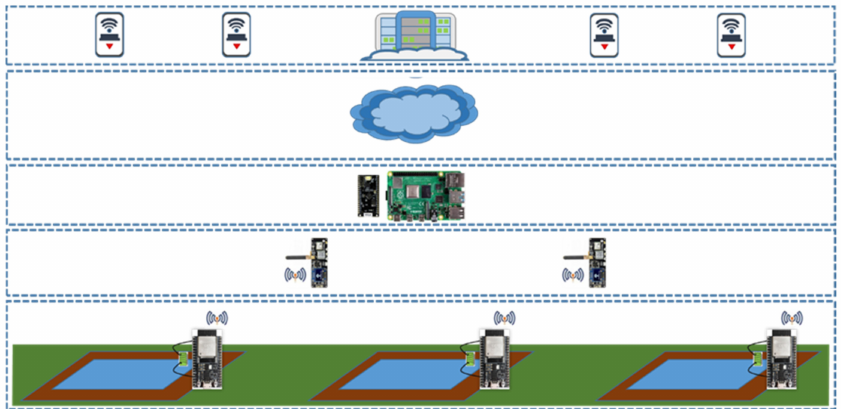
Figure 2. Architecture employing Wi-Fi and LoRa